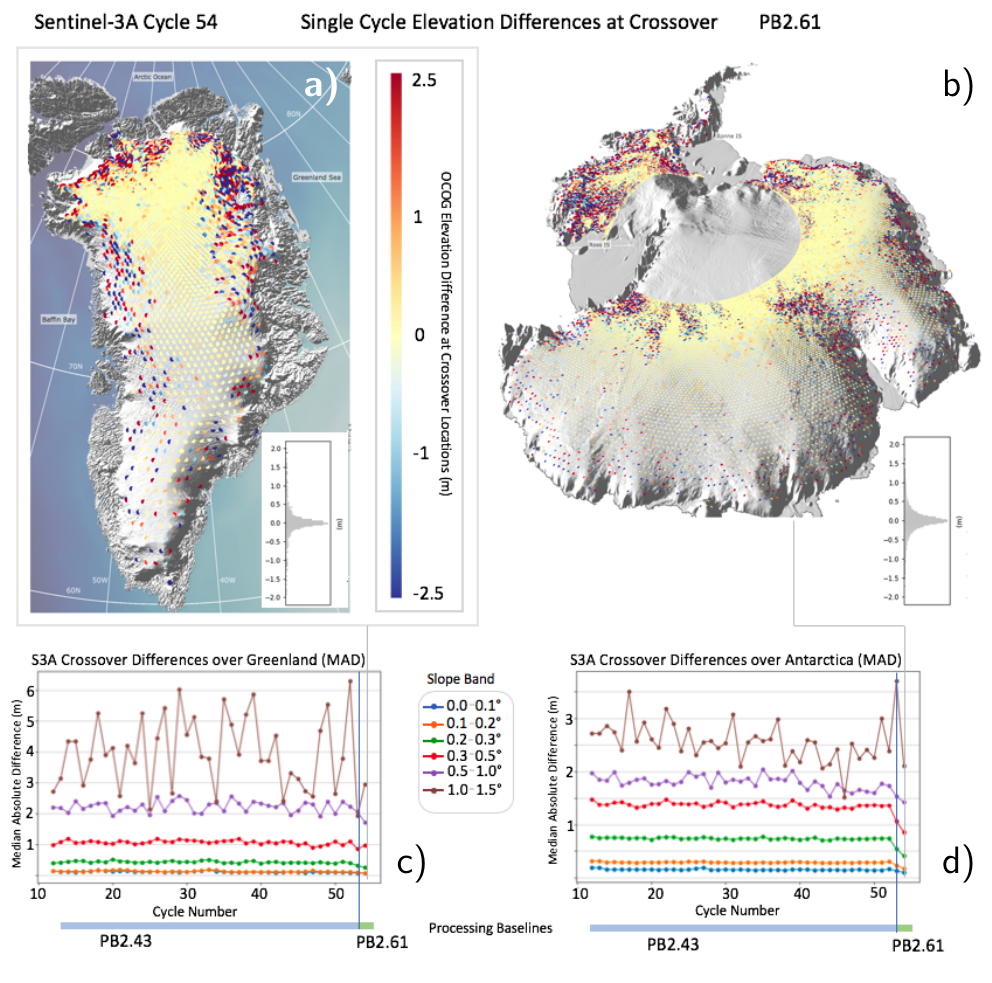
Figure 34. OCOG elevation differences at single cycle orbit crossover locations over the ( a ) Greenland and ( b ) Antarctic ice sheets, and ( c , d ) mission time series of the Median Absolute Difference (MAD) of crossover differences per band of surface slope. The vertical lines highlight the impact of the change in